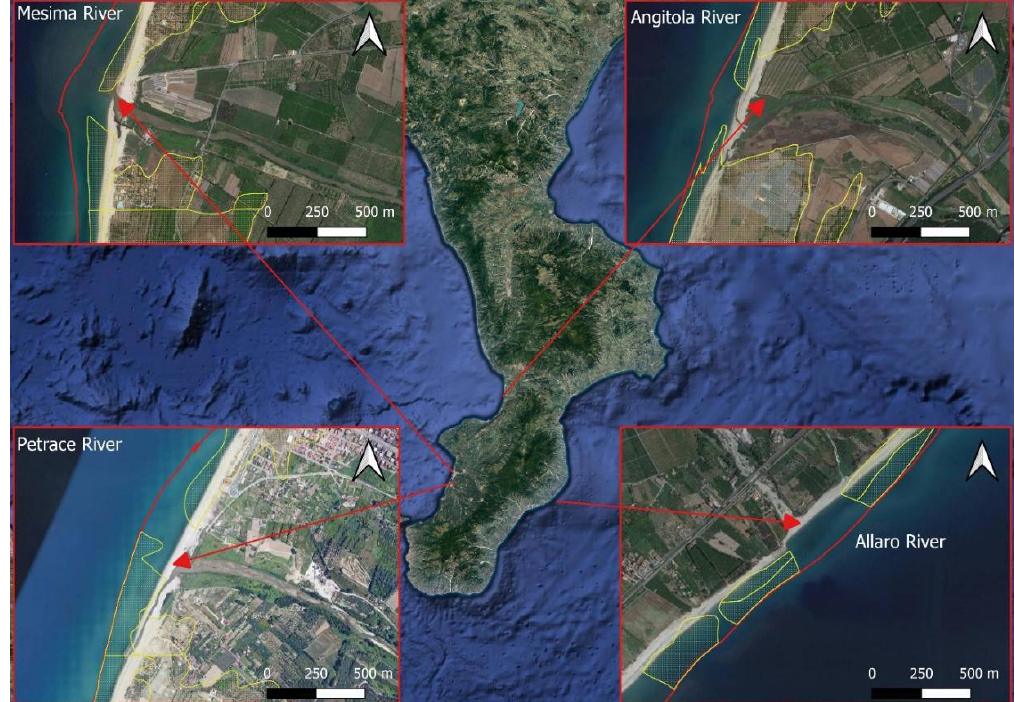
Figure 3. Shoreline erosions near river mouths. Legend: red line = shoreline of 1954; yellow dotted area = dune systems of 1950s; background = most recent Google satellite images.